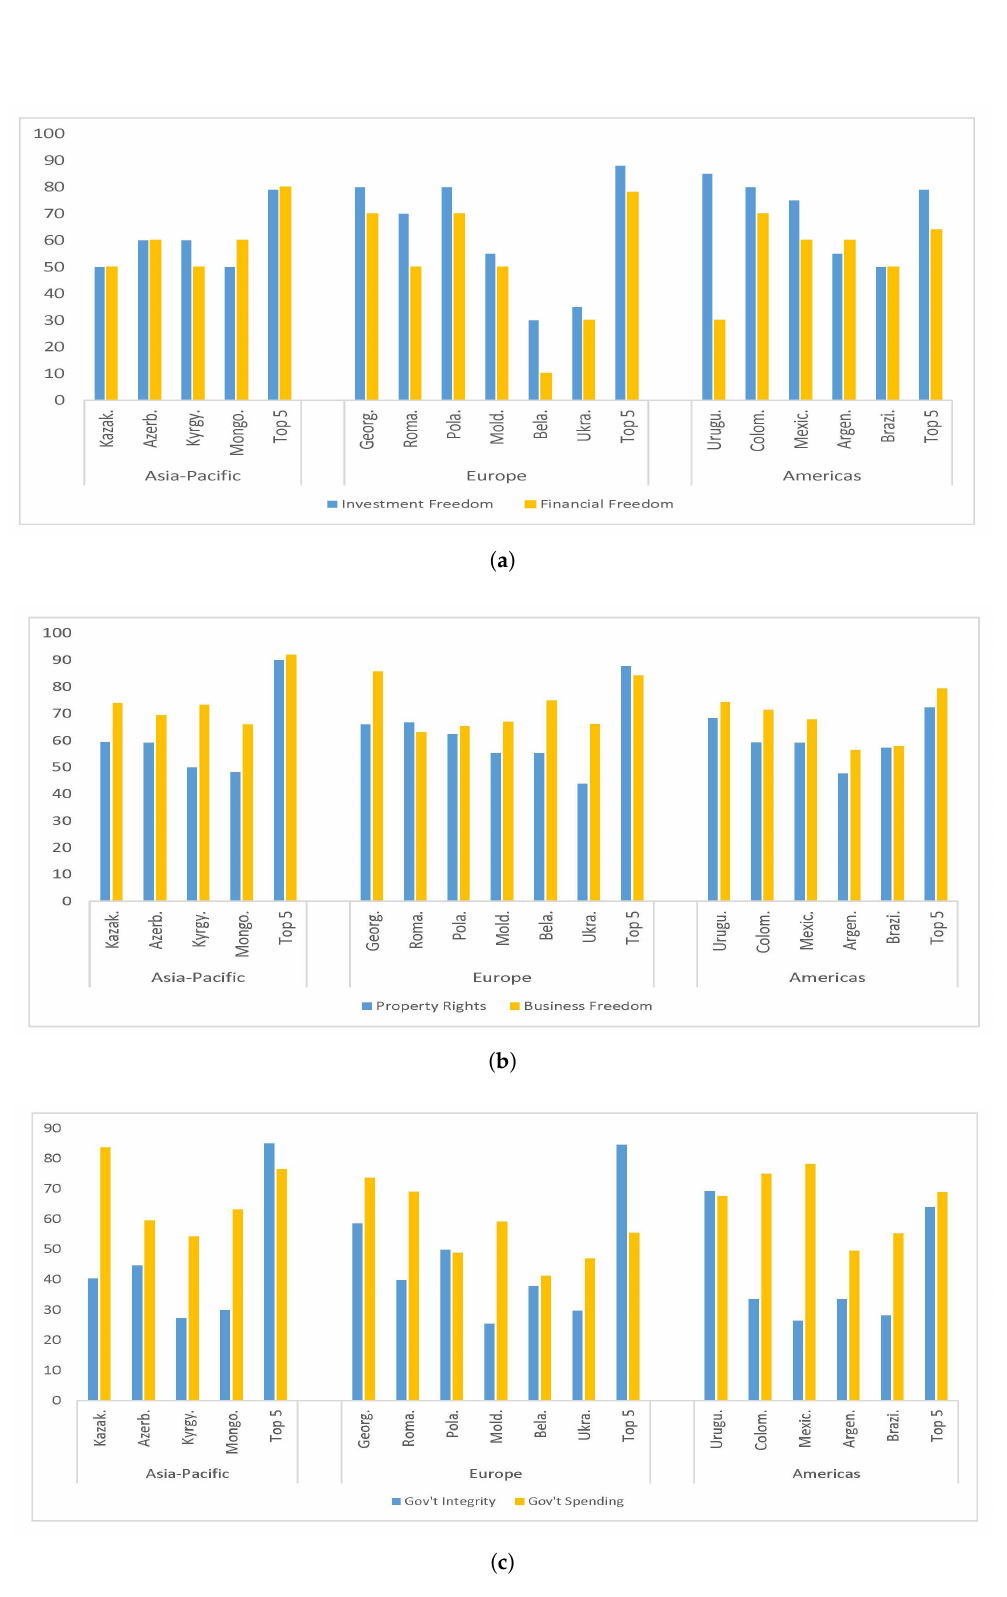
Figure 4. Economic Freedom Components, Selected countries, 2019. Data obtained from the Index of Economic Freedom [(Heritage Foundation 2020)]. ( a ) contains Investment freedom and Financial freedom, ( b ) Property rights and Business freedom, while ( c ) displays measures of government integrity and government